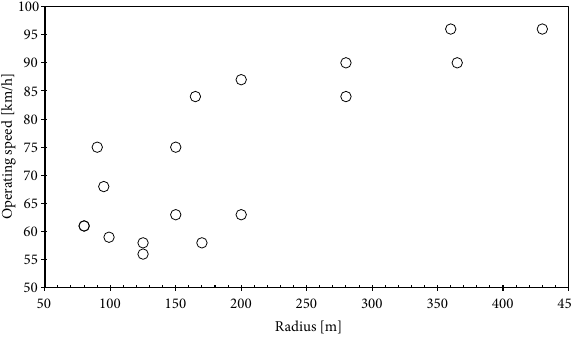
Figure 4. Effect of curve radius on operating